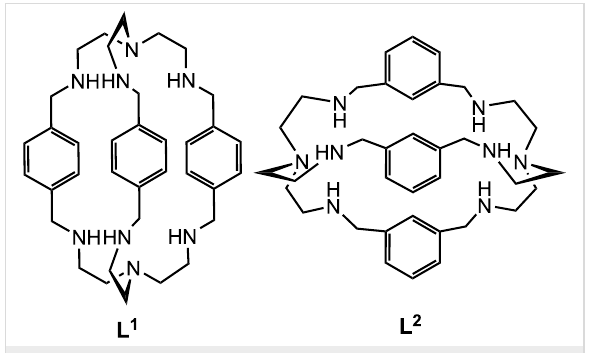
Figure 1: Octaaminocryptand with p -xylyl spacers L 1 , with m -xylyl spacers L 2 .